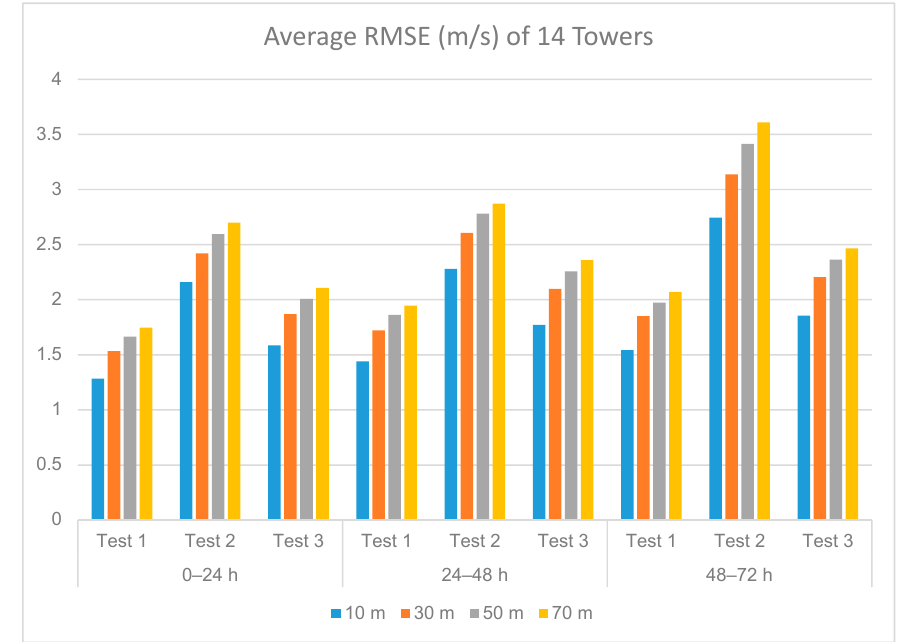
Figure 16. Wind speed RMSE of sensitivity test results.